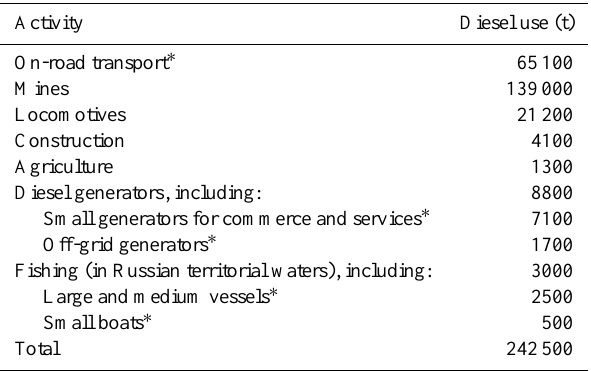
Table 3. Estimated diesel consumption by sector in the Murmansk Region,